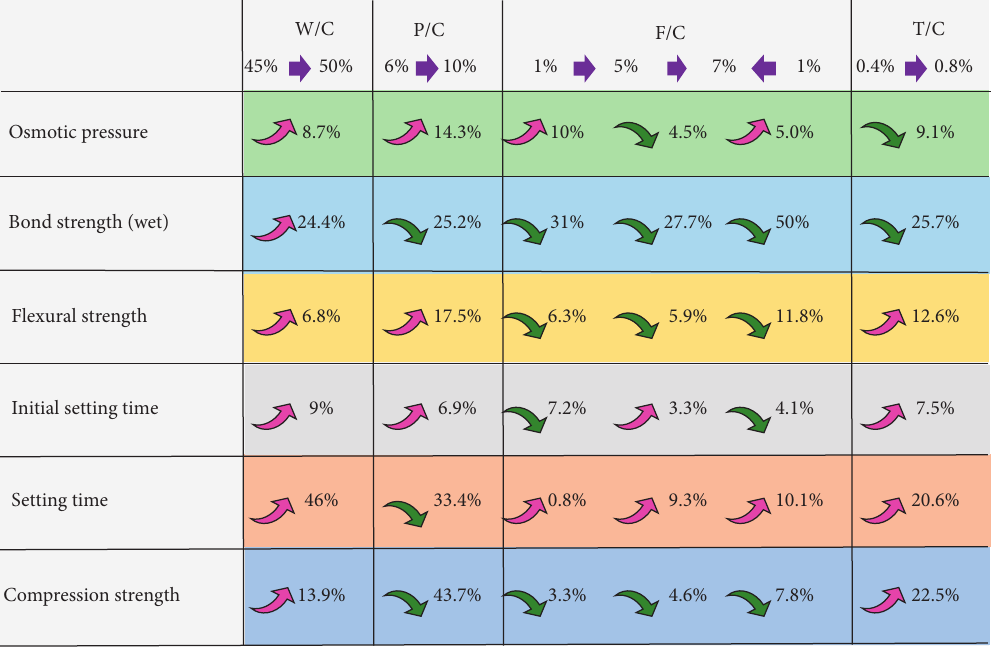
Figure 15: Influence of gradient changes of different factors on the wet wall on